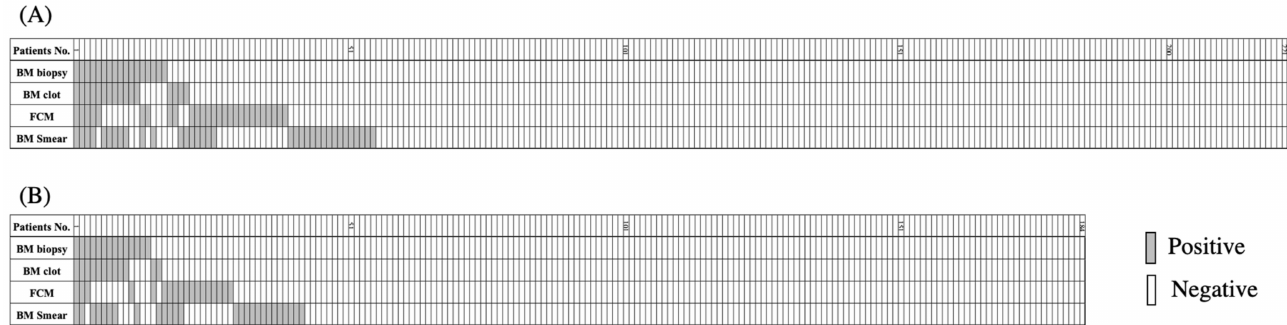
Figure 1. Results of bone marrow (BM) examination via four modalities. ( A ) all patients and ( B ) patients initially treated with R-CHOP or R-CHOP-like regimen. FCM, flow cytometry; smear, microscopic examination of BM aspirate smear section. Gray boxes indicate patients with a positive result, and white boxes indicate patients with a negative result.